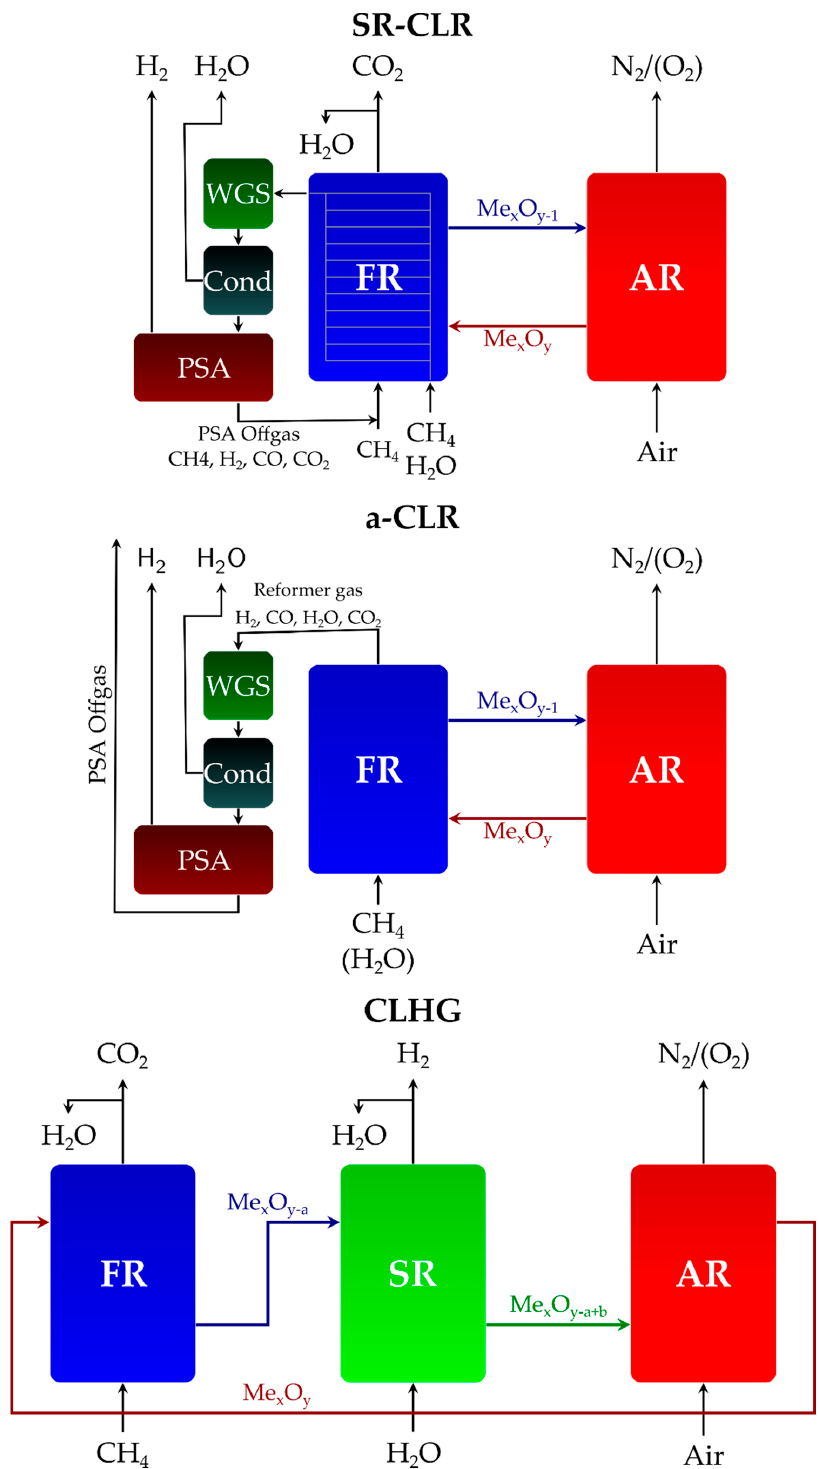
Figure 7. Process schemes of steam reforming-chemical looping reforming (SR-CLR), autothermal chemical looping reforming (a-CLR), and chemical looping for hydrogen generation, adapted from [105,107,111]. Acronyms include FR: fuel reactor, AR: air reactor, WGS: water-gas shift reactor, Cond: condenser, PSA: pressure swing adsorption unit, and SR: steam